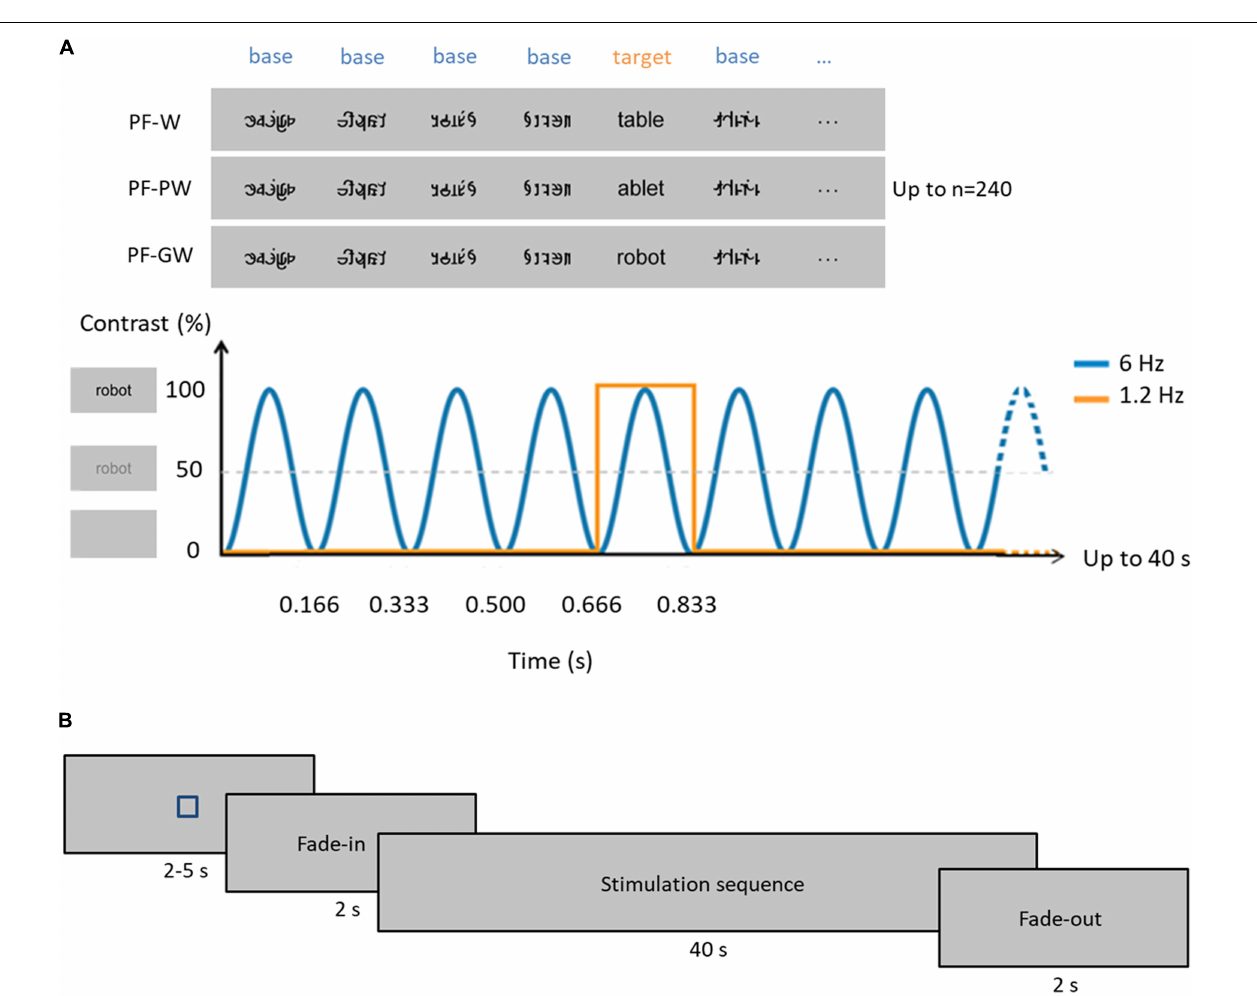
FIGURE 1 | Experimental paradigm. (A) In each condition, base stimuli were pseudofonts (top, middle, and bottom rows), and target stimuli were either control words (W, top row), pseudowords (PW, middle row) or globally taught words (GW, bottom row) appearing every fifth item. Each sequence lasted 40 s, during which stimuli were presented by sinusoidal contrast modulation at 6 Hz, each stimulus reaching full contrast after 83 ms (i.e., one cycle duration = 166.66 ms). Stimulation alternated between base (B) and target (T) stimuli such as BBBBTBBBBTBBB. Target stimuli therefore appeared at 6 Hz/5, so at 1.2 Hz. Stimuli were randomly presented with no immediate repetition and appeared continuously on the screen. In total, 240 stimuli were presented per sequence (48 target stimuli and 192 base stimuli), and each condition was repeated three times. (B) Timeline of a sequence: each sequence started with a fixation square (for 2–5 s) after which the stimulation faded in (for 2 s) then reached full contrast (for 40 s) and then faded out (for 2 s) (see section “Materials and